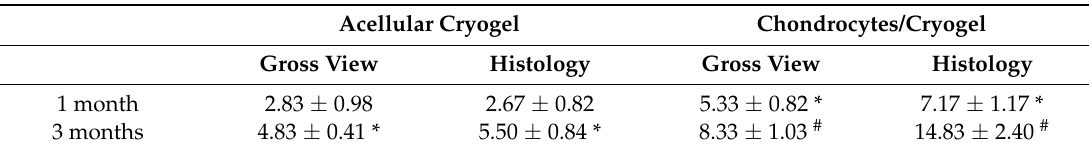
Table 3. Semi-quantitative analysis of articular cartilage defect repair 1 and 3 months post-implantation by ICRS scores. Values are mean ± SD from six